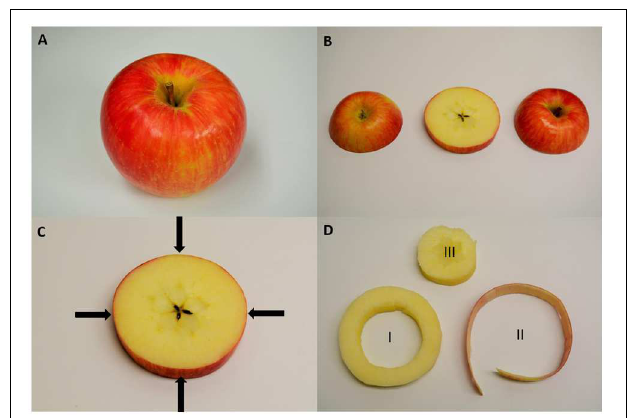
FIGURE 1 | Sampling protocol of a ‘Honeycrisp’ apple for handheld x-ray fluorescence (XRF) and destructive lab sampling. (A) Whole apple where four measurements were made with the handheld XRF along the equator of the fruit. (B) To compare handheld XRF, an equatorial slice was removed from the apple. (C) A representation of the sampling locations for handheld XRF analysis. (D) Destructive sampling for elemental analysis of (I) the outer cortex of the apple used for analysis of homogenized pellets using the handheld XRF and then digesting for lab elemental analysis, (II) apple peel to compare with handheld XRF measurements made along the equatorial region of the fruit while it was whole, and (III) the core of the apple which was